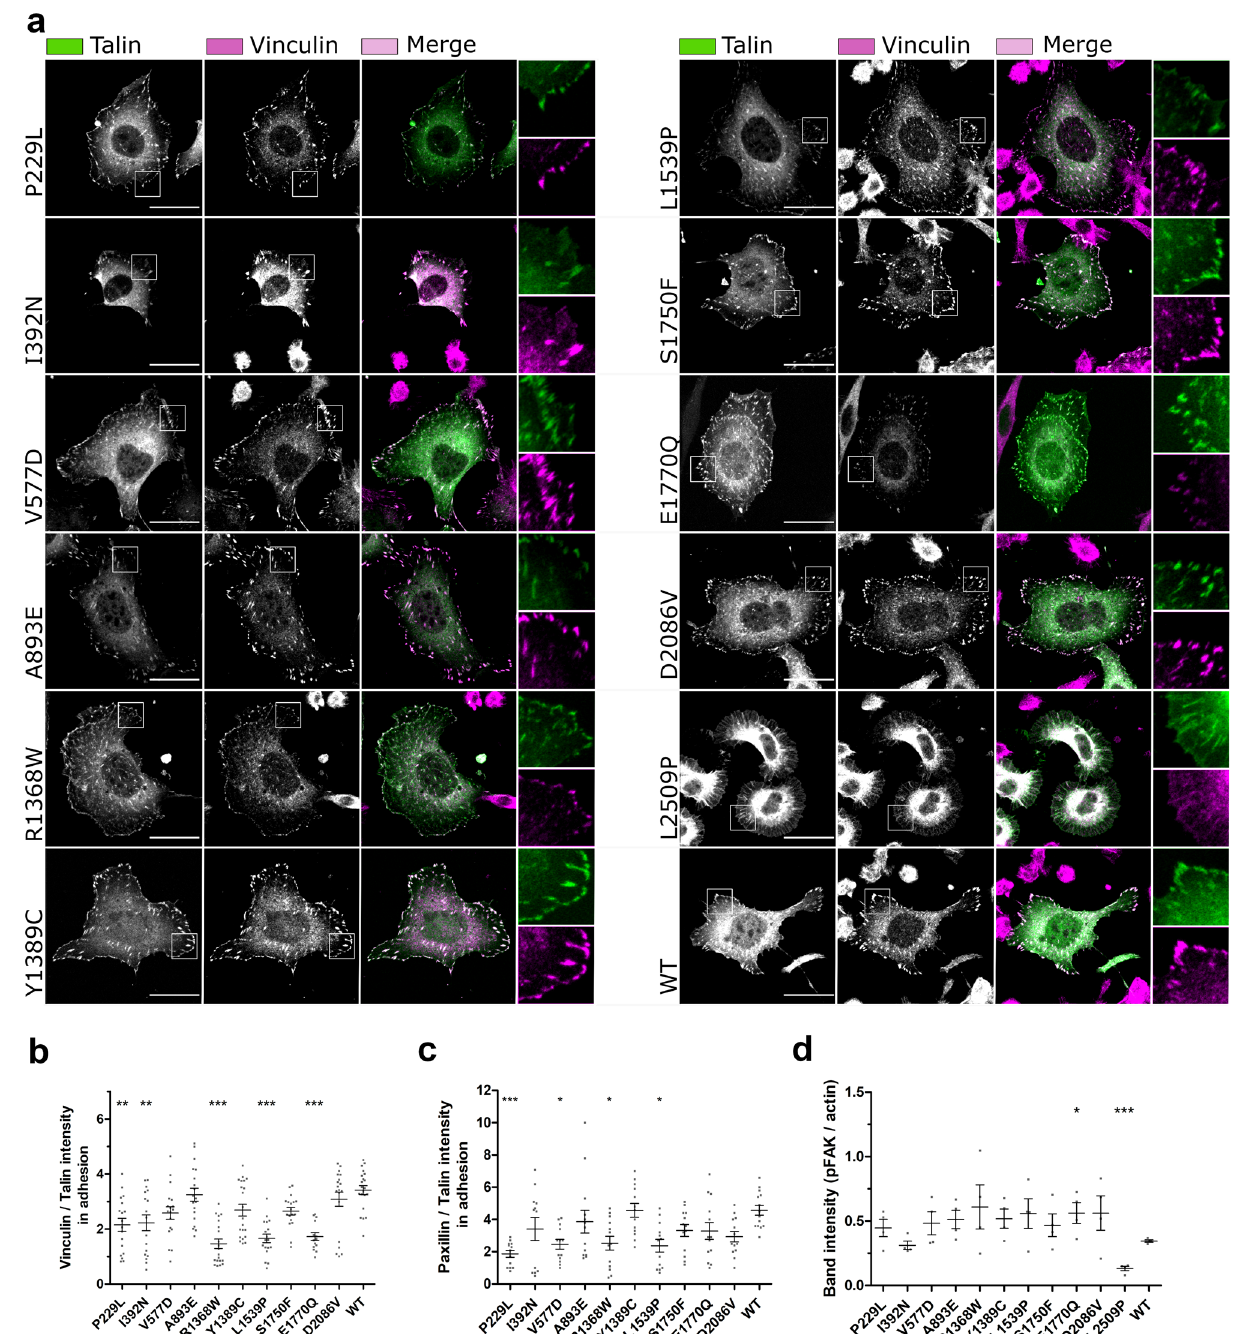
Figure 4. Talin mutations influence the colocalization with vinculin, paxillin and pFAK. ( a ) SUM projections of z–stacks of TLN1 –/– TLN2 –/– mouse kidney fibroblast cells expressing GFP–tagged talin-1 forms and immunolabeled for vinculin. Scale bars are 25 µm, zoom–in square size is 12.5 µm × 12.5 µm. ( b , c ) Analysis of vinculin ( b ) and paxillin ( d ) colocalisation with talin in adhesions; n ~ 20 cells per mutation from two separate experiments. ( d ) FAKpTyr397 expression levels quantified from four western blots. The statistical significance in ( b , c ) was analysed by one-way ANOVA and Bonferroni test: *P < 0.05, **P < 0.01, ***P < 0.001. The statistical analysis in ( d ) was calculated by unpaired